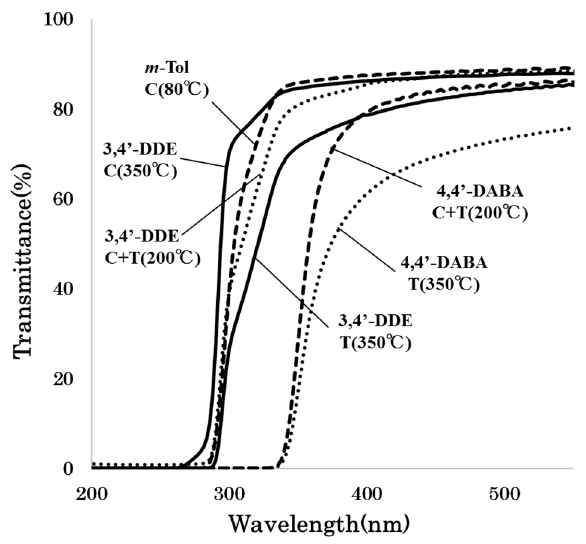
Figure 7. The UV-vis transmission spectra of the polyimide films prepared from CpODA and aromatic diamines by three different methods. T: thermal imidization (350 ◦ C), C + T: combined chemical and thermal imidization (200 ◦ C), C: chemical imidization (80–350 ◦ C). The thickness and refractive index at three points of the polyimide film were measured using a Metricon Model 2010/M Prism Coupler [35]. The in-plane and out-of-plane retardations (R0 and Rth) of the polyimide film are given by the following equations, where nx, ny, and nz are refractive indexes of x, y, and z axis directions, and d denotes thickness of the film in nm unit (Figure 8a).